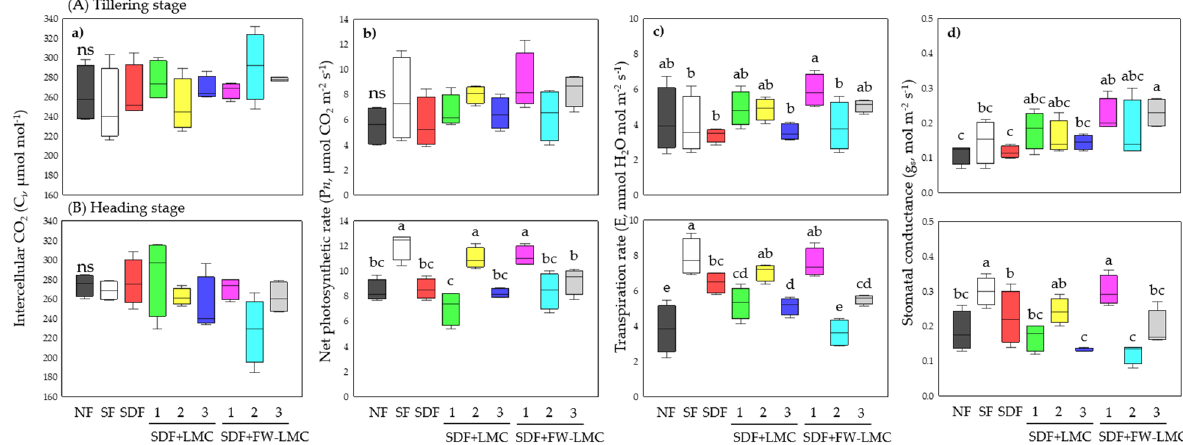
Fig. 2 Photosynthetic performance at tillering and heading stages affected by varying types and rates of fertilization. Rice plants were taken with three replications (2 plants/repeat). Different letters mean a statistical significance at 0.05 (n